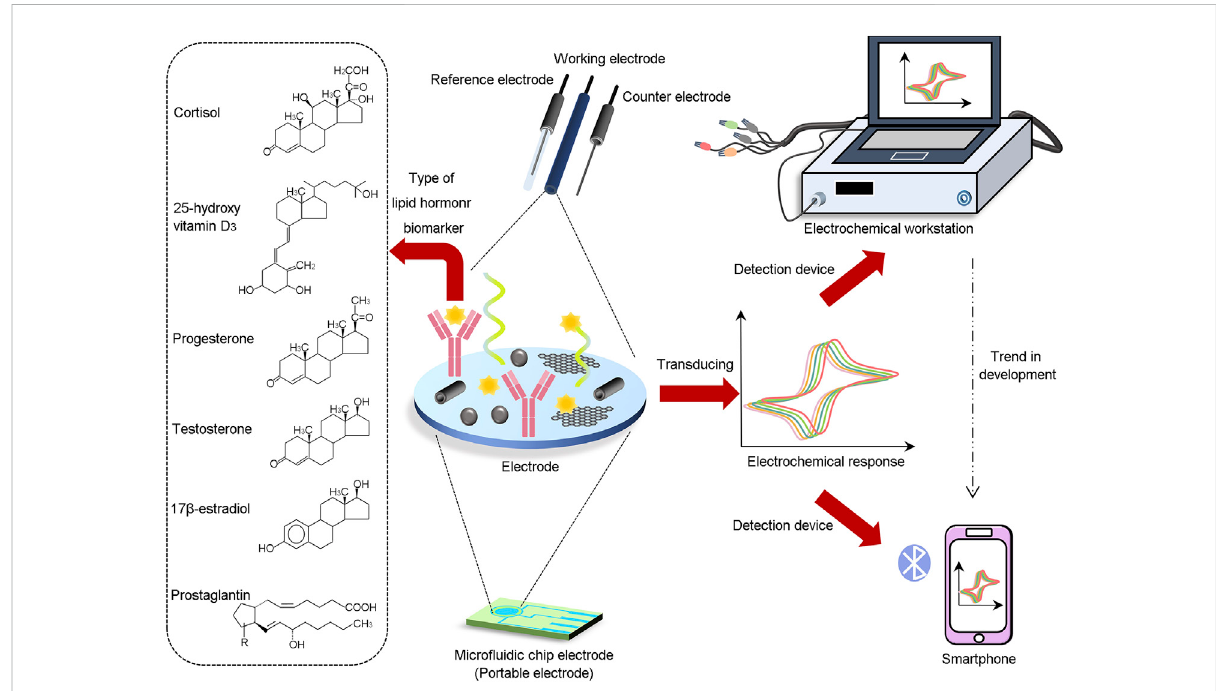
FIGURE 1 Schematic representation of the electrochemical biosensor for detection of lipid